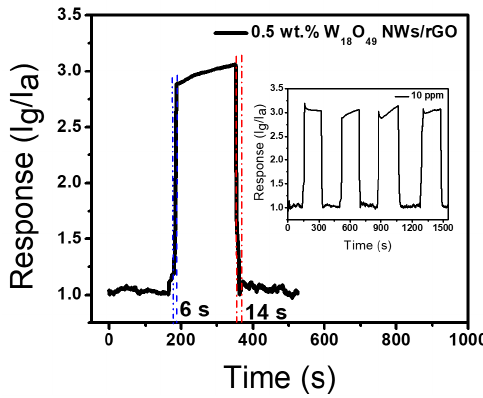
Figure 6. Response and recovery time measurement of sensor based on the 0.5 wt. % W 18 O 49 NWs/rGO composite to 10 ppm toluene vapor at 300 °C. The inset is the repeatable response–recovery curves to 10 ppm toluene vapor at 300 °C.